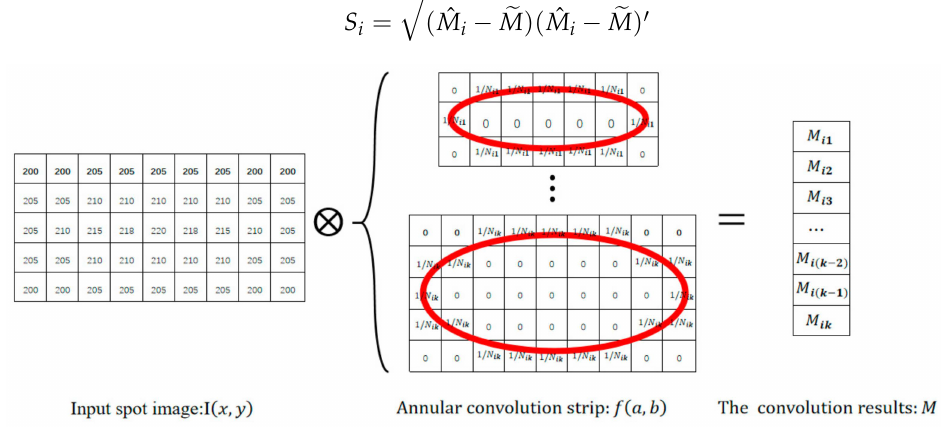
Figure 2. The process of the convolution operation.